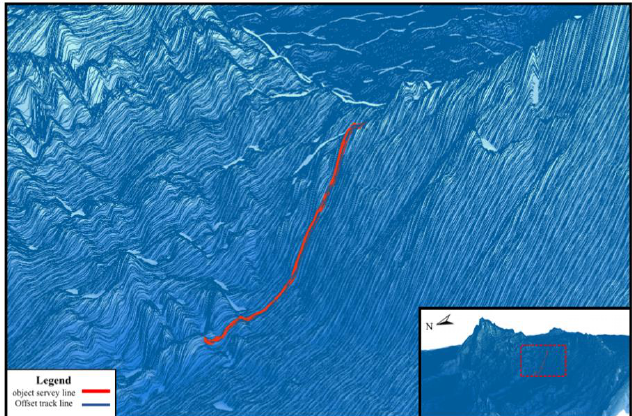
Figure 9. Schematic diagram of the offset trajectory line.